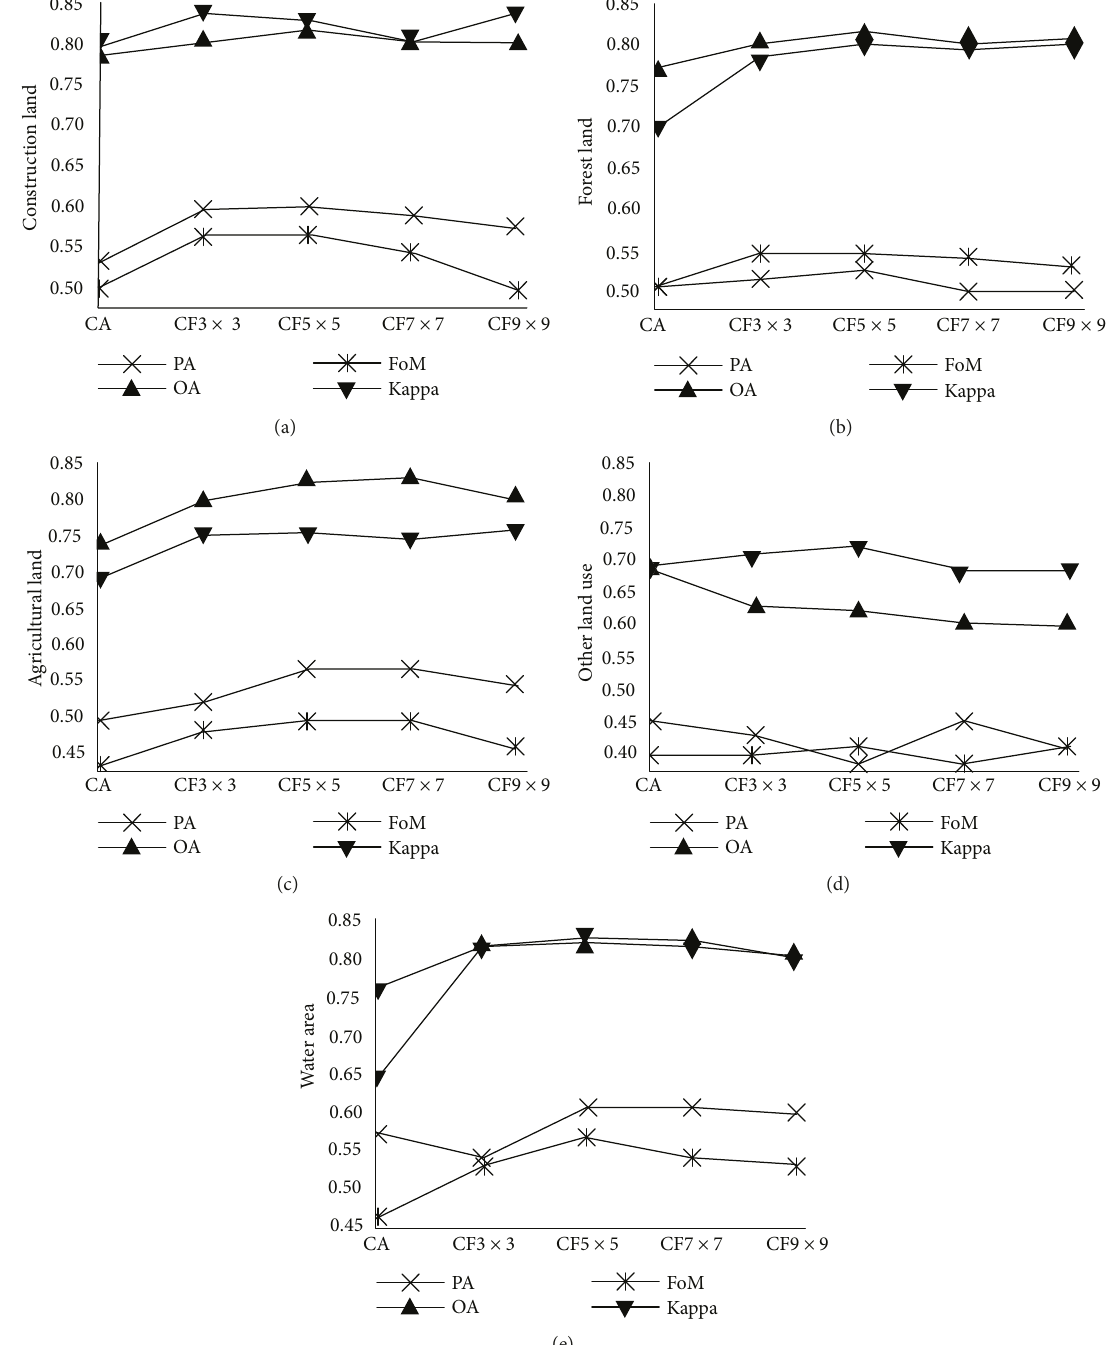
Figure 5: Comparison of simulation accuracy of land use types under di ff erent neighborhood scales under the traditional CA and fuzzy CA models (CA is the PA, OA, FoM, and Kappa parameter values of the traditional CA model; CF3 × 3, CF5 × 5, CF7 × 7, and CF9 × 9 are the fuzzy CA models at 3m × 3 m, 5 m × 5m, 7m × 7m, and 9m × 9m neighborhood cells with di ff erent PA, OA, FoM, and Kappa parameter